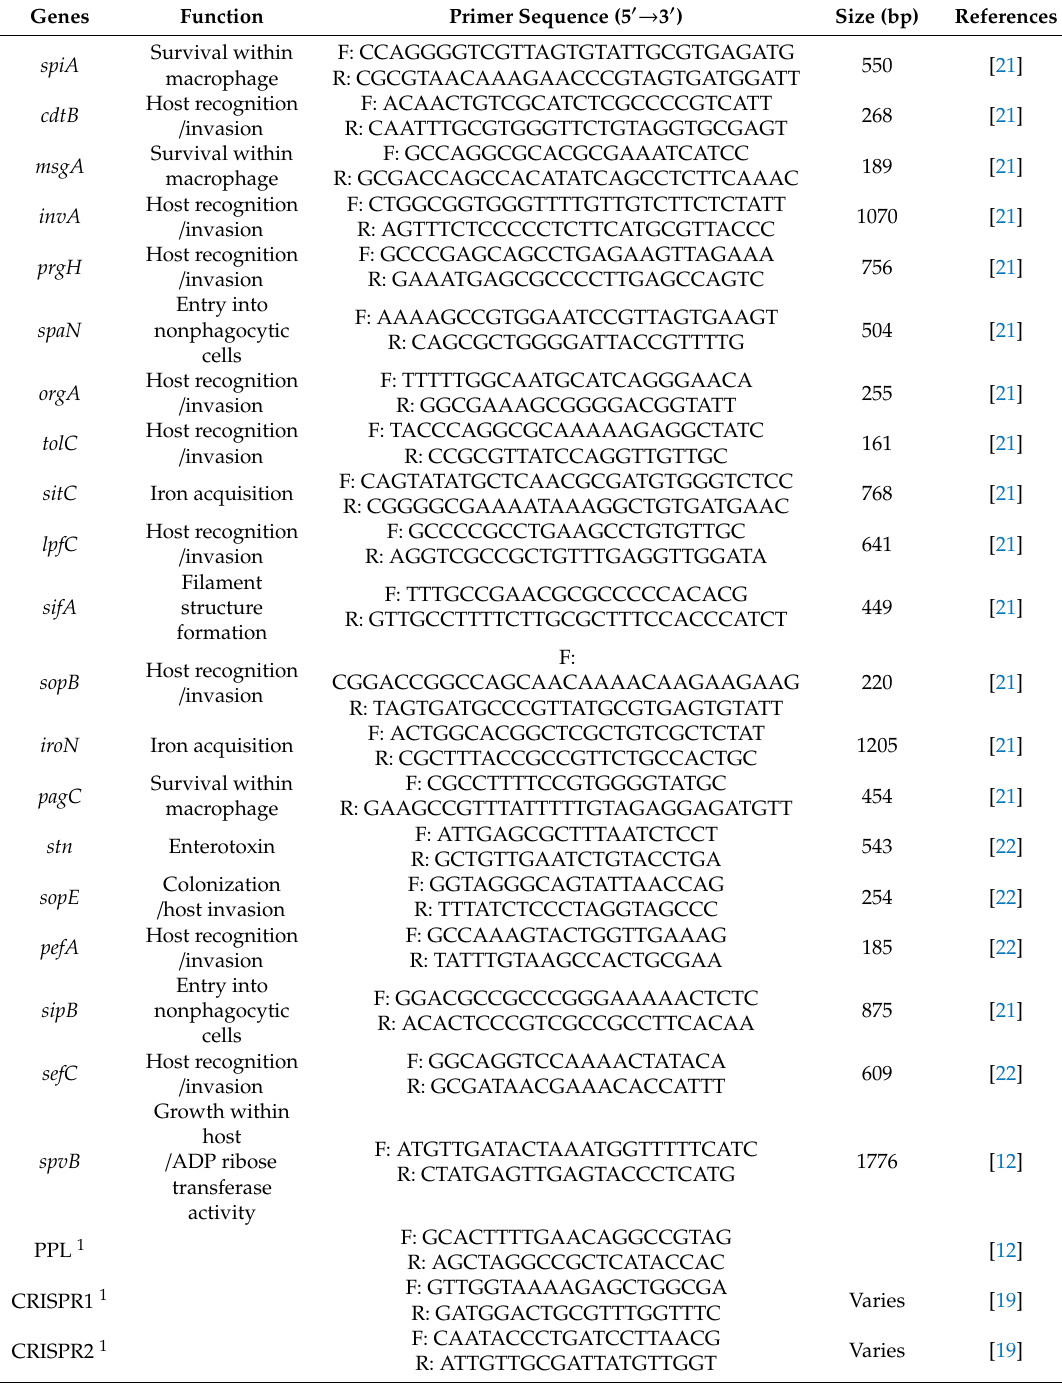
Table 1. Primers used in this